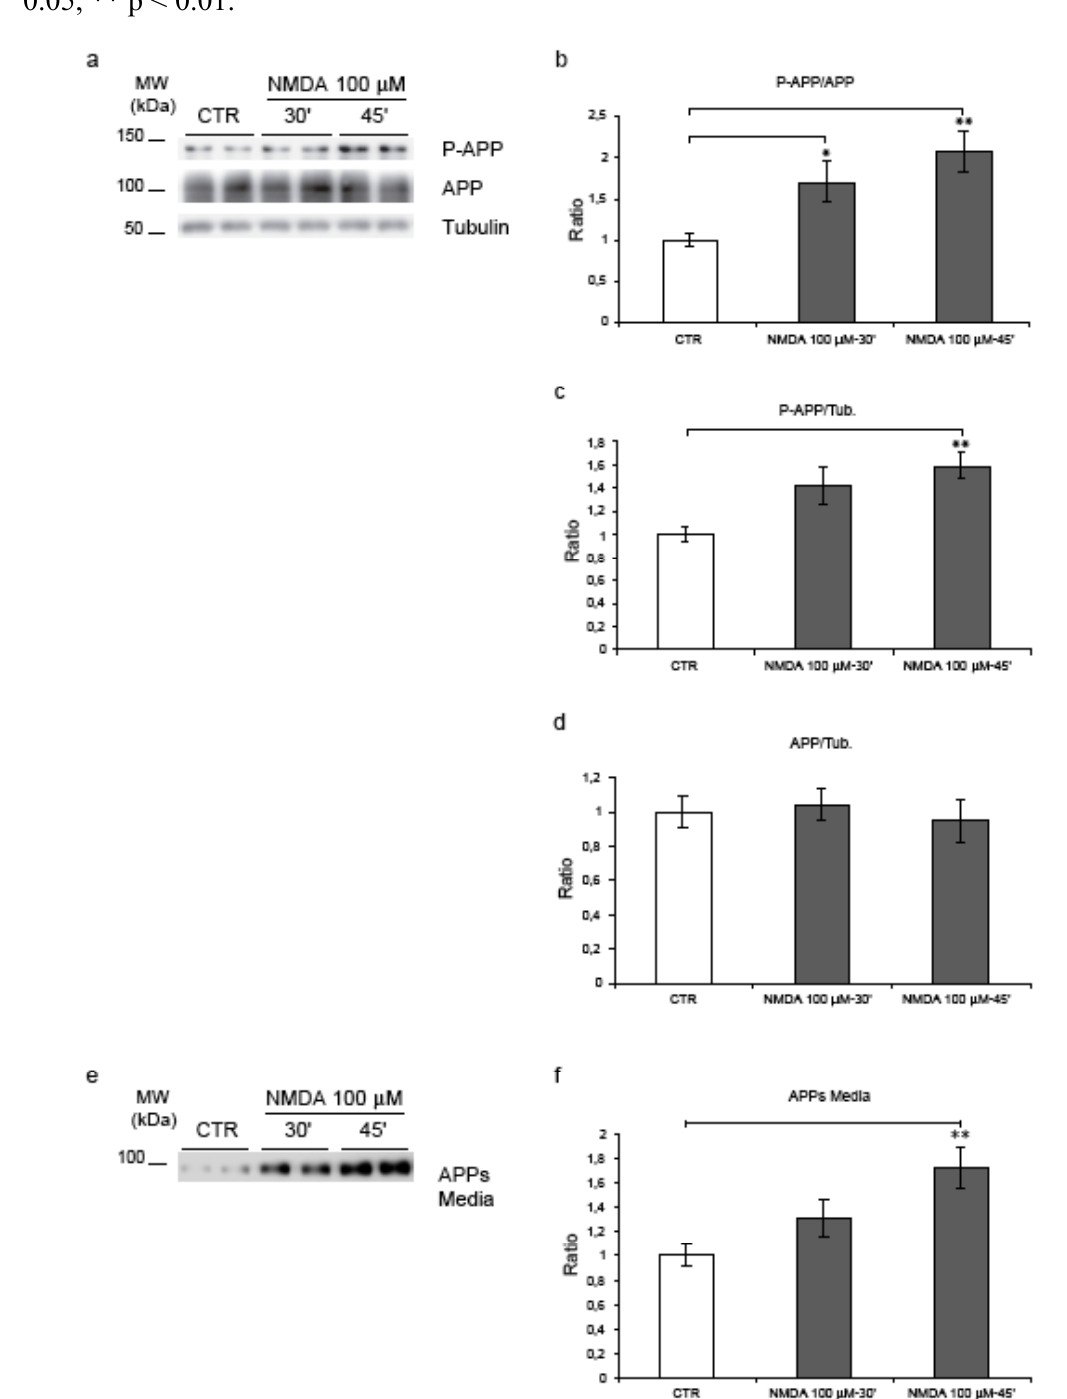
Figure 2. NMDA application induces APP hyperphosphorylation. (a) Neurons were exposed to NMDA (30’-45’), cell lysates were immunoblotted for P-APP and total-APP. Loading control: Tubulin. (b) Quantification showed that NMDA increased P-APP level (P-APP/APP ratio), at 30’ (70%) and 45’ (110%). (c) NMDA increased P-APP/Tub ratio after 45’ (60%). (d) NMDA did not affect the total-APP protein level (APP/Tub). (e) Proteins from culture media were blotted for total-APP secreted (APPs). Loading control: Total medium proteins identified with Coomassie Blue. (f) NMDA-45’ treatment increased APPs level (70%). Quantifications are from six independent experiments (±S.E.M.), * p < 0.05, ** p <